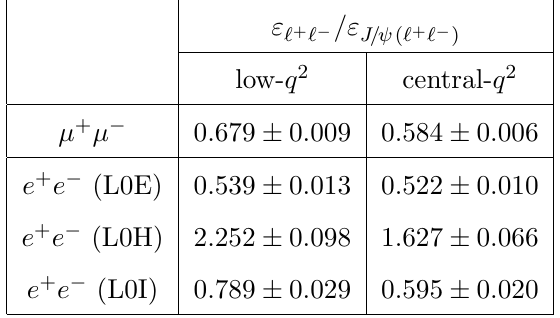
=" , for the ‘ + ‘ (cid:0) J= ( ‘ + ‘ (cid:0) )